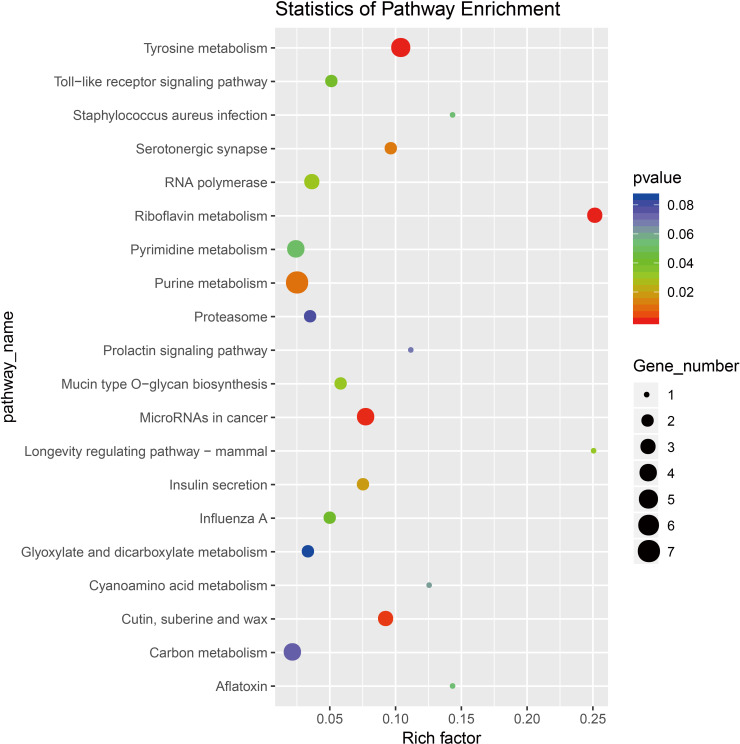
Transcriptomic analysis of the differentially expressed genes in the P. xylostella larva after (3E)-4,8-dimethyl-1,3,7-nonatriene (DMNT) treatment at 12 hr.Kyoto Encyclopedia of Genes and Genomes (KEGG) analysis of the pathway enrichment from the differently expressed genes after DMNT treatment is shown.